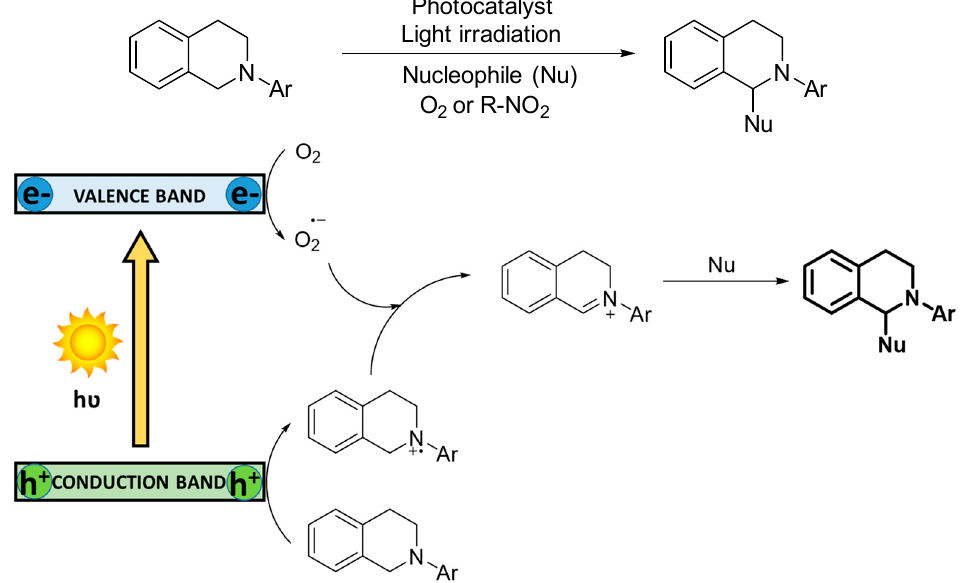
(Nu)Photocatalyst Light irradiation O 2 or R-NO